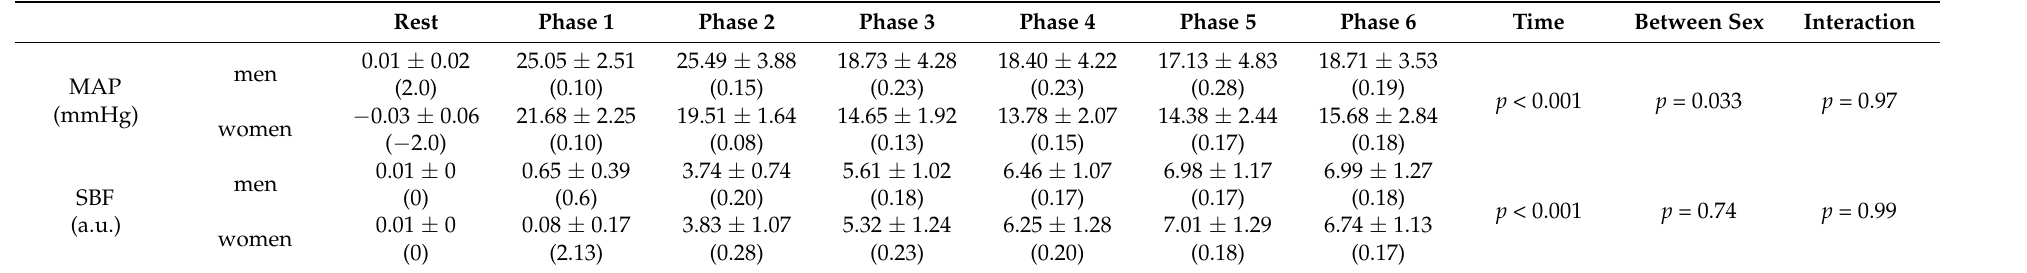
Table 4. Changes in MAP and SBF during exercise, from